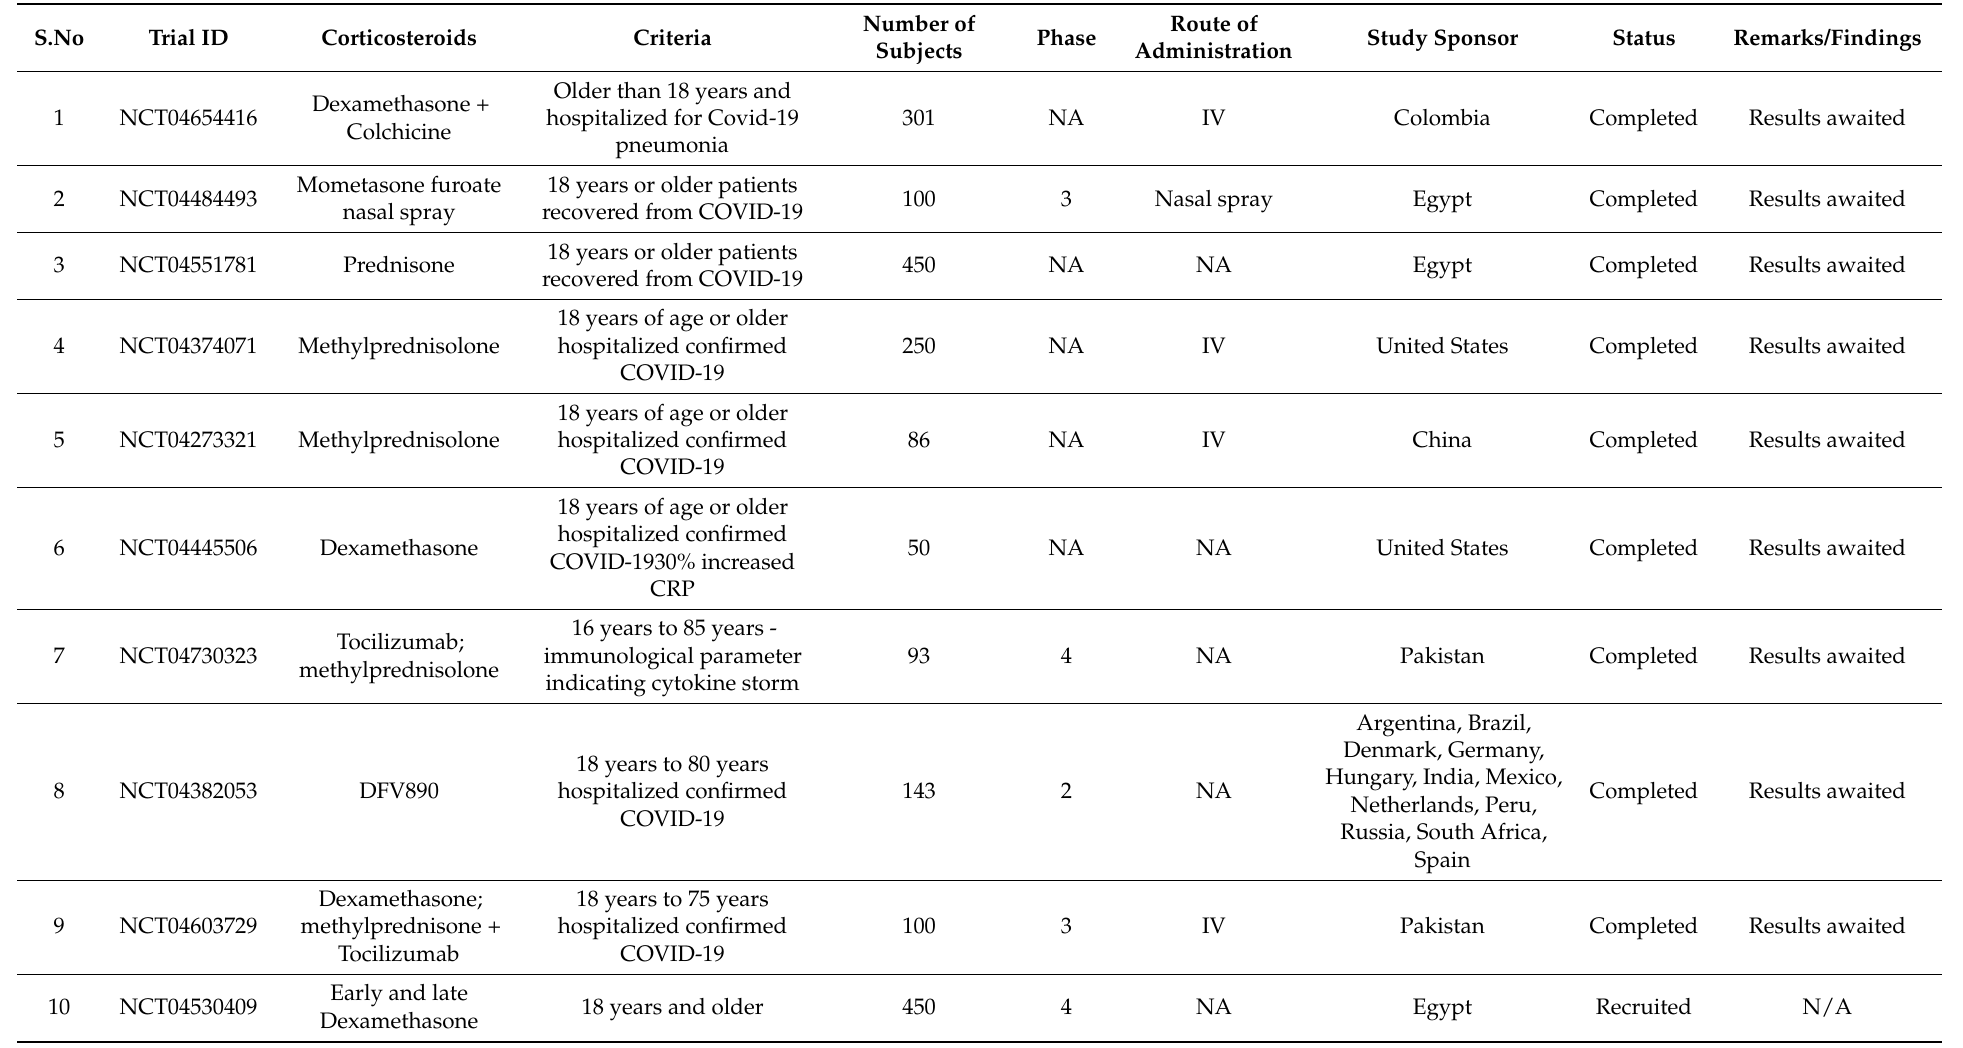
Table 3. Summary of currently ongoing clinical trials that evaluate the usefulness of corticosteroids for the treatment of COVID-19